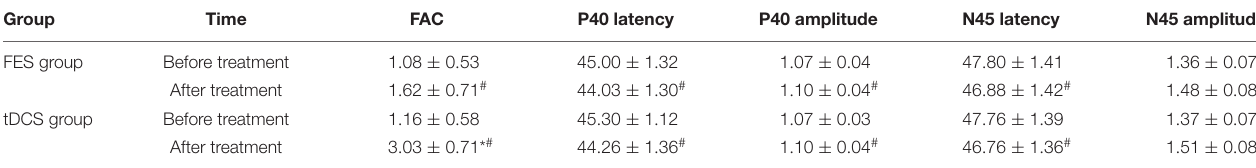
TABLE 3 | The difference in index scores before and after treatment.